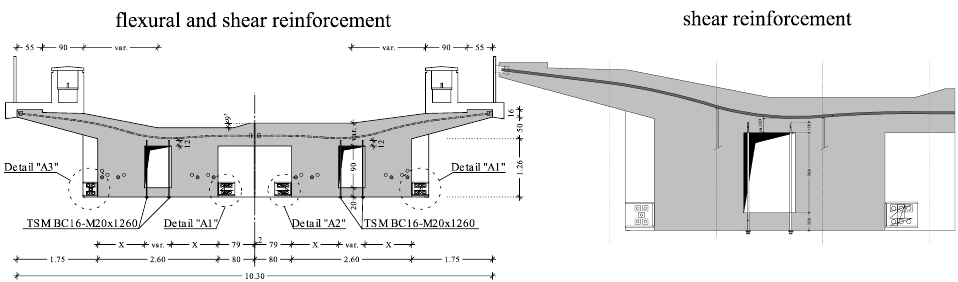
Figure 4. Additional flexural reinforcement on both sides of the hollow box girder and additional shear reinforcement drilled through the hollow box.